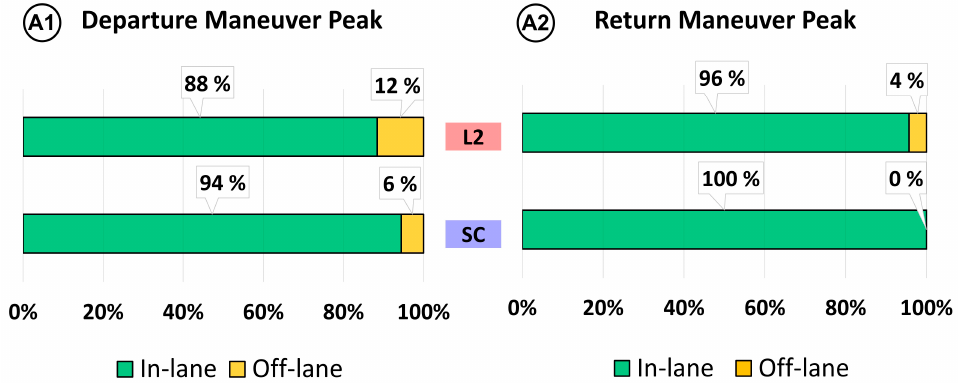
Figure 12. Event analysis of successful overtaking (maneuver A).